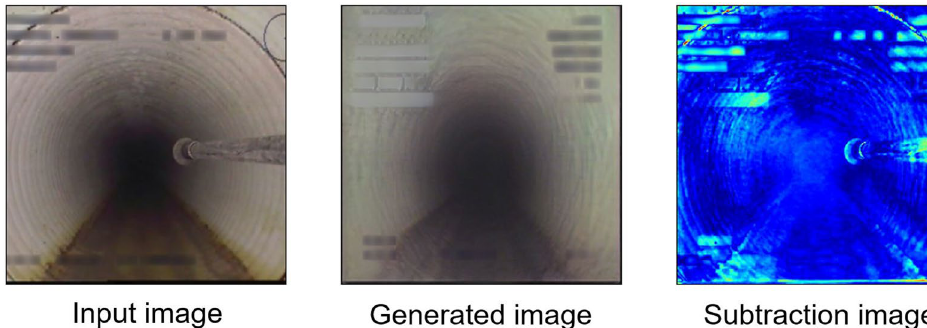
Fig. 19 Experimental results of normal pipe (GAN)